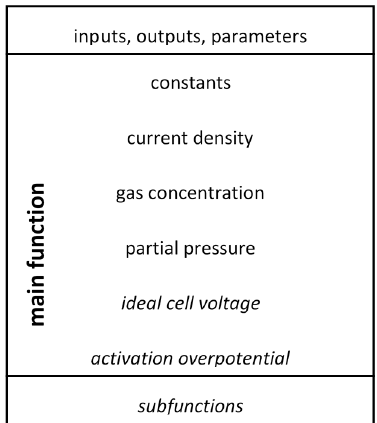
Figure 1. Model structure and calculation order. Italic functions are implemented as a subfunction.